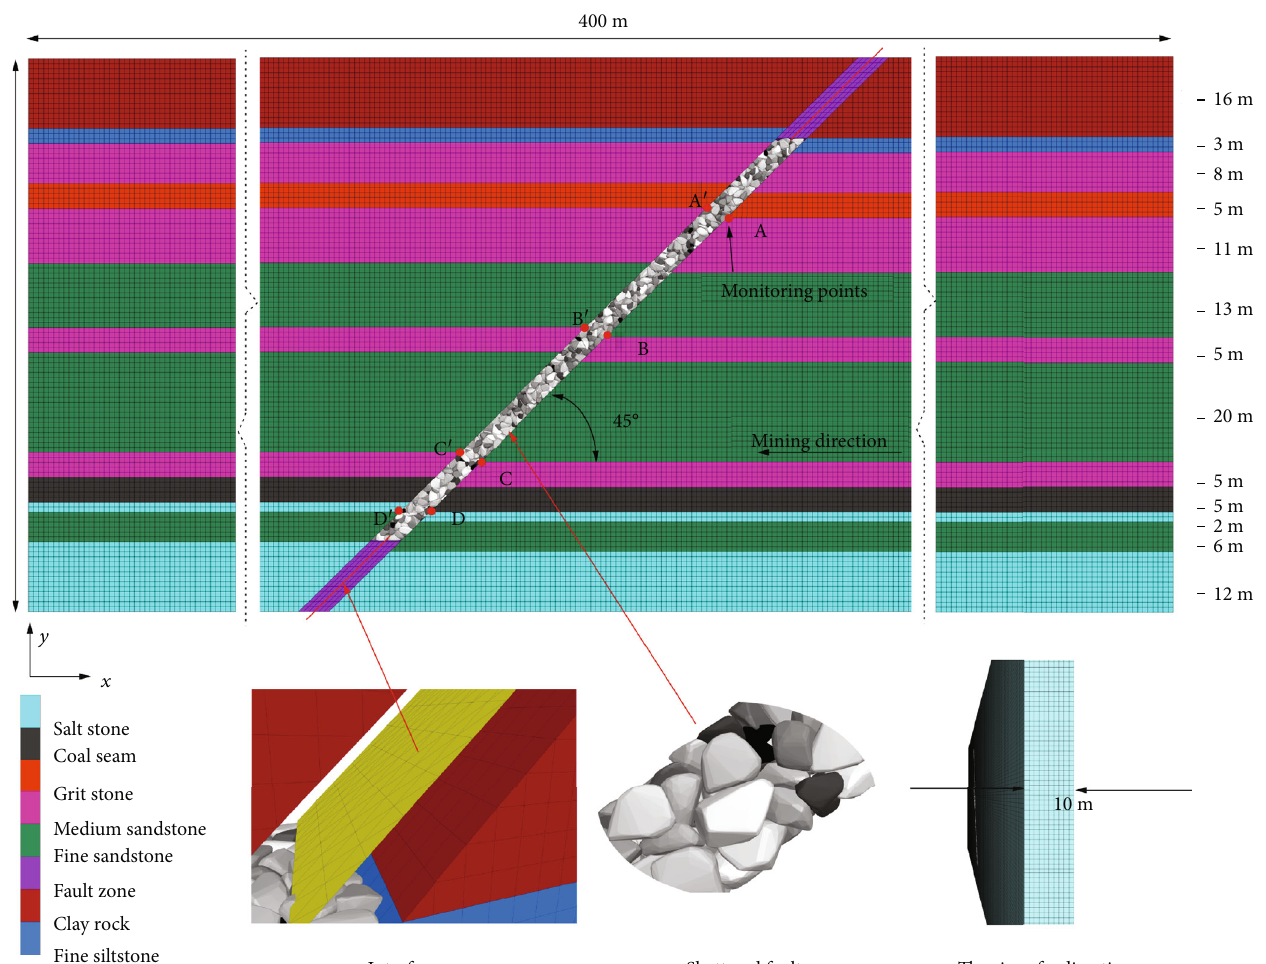
Figure 2: 3D dimensions of the numerical